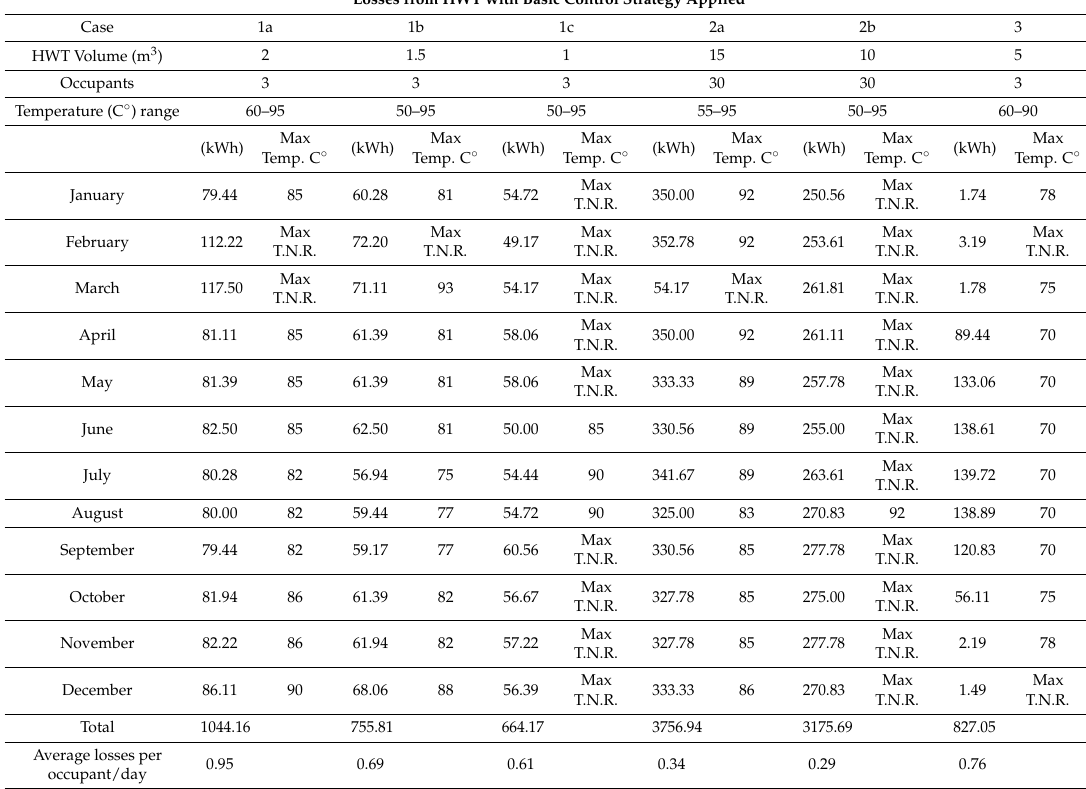
Table 6. Thermal energy losses (kWh) computed by setting maximum temperature values depending on every month. To note that not for every month maximum temperature was regulated (Max T. Not Regulated cells). As in these months, the temperature goes below minimum values, the energy demand cannot be fully satisfied. However, the system works at 100% of its